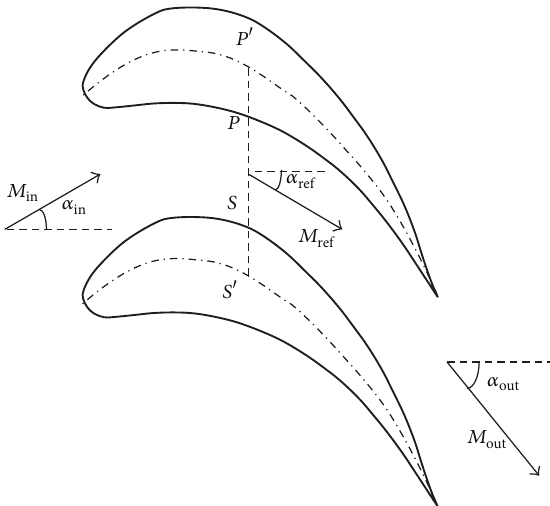
Figure 3: Cross section for compressibility correction.